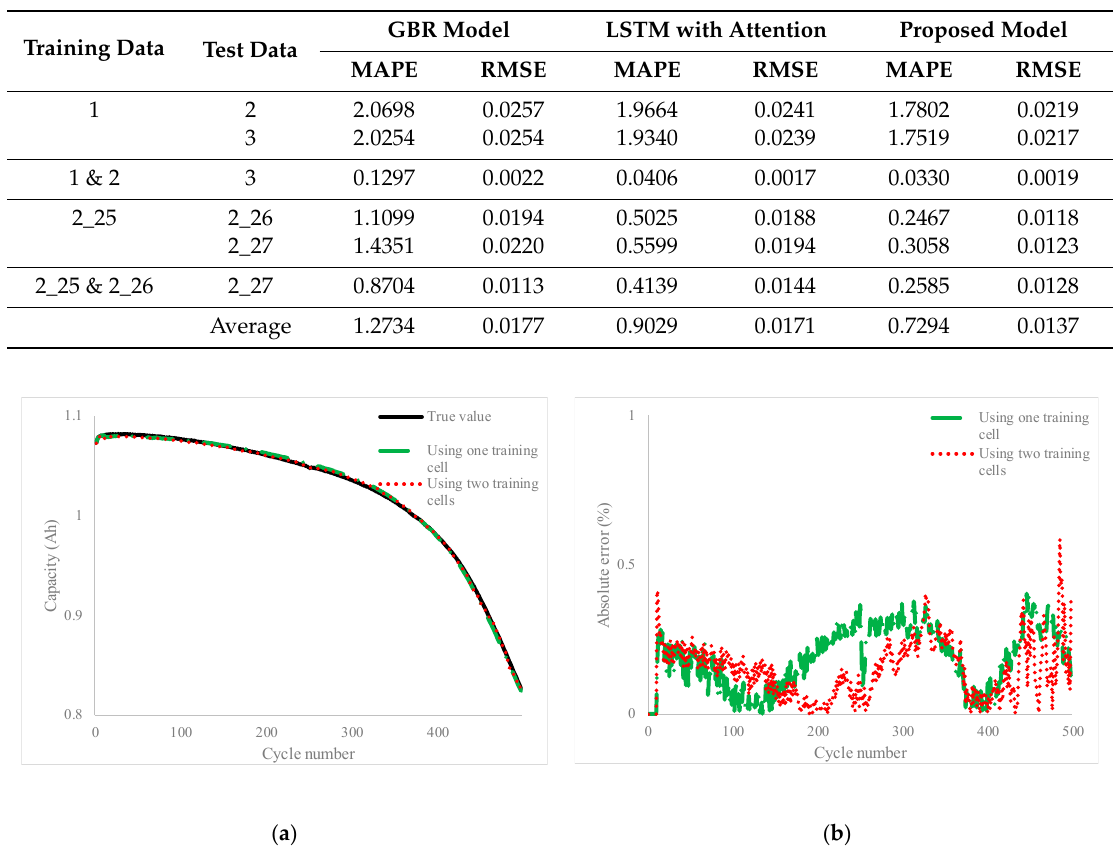
Figure 6. The prediction performance of the proposed model using one cell or two cells as training data for cell 2_27: ( a ) predicted capacity and ( b ) absolute prediction error.